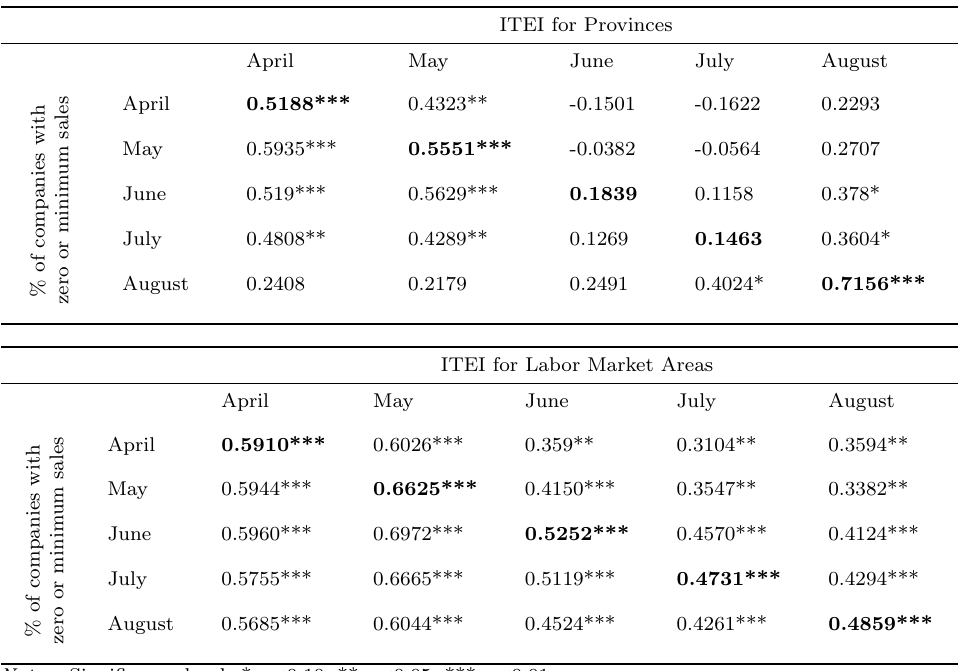
Table 2: Pearson’s correlations between ITEI values and companies in a critical